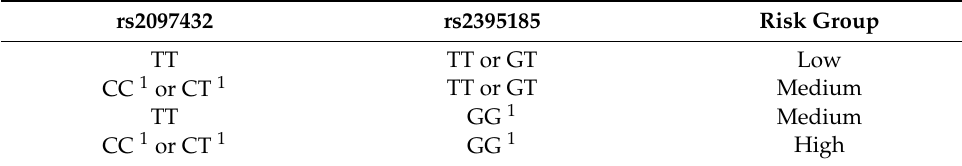
Table 3. Classification of haplotype and risk of anti-TNF drug response.